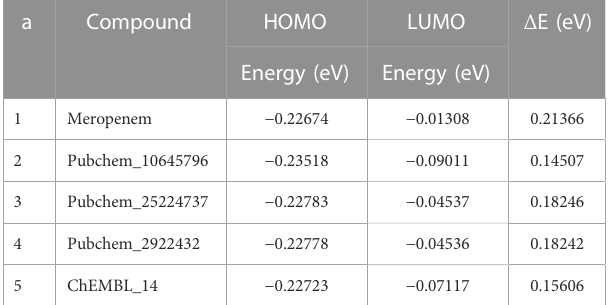
TABLE 7 Calculation of HOMO – LUMO values by B3LYP/6-31+G* methods. a